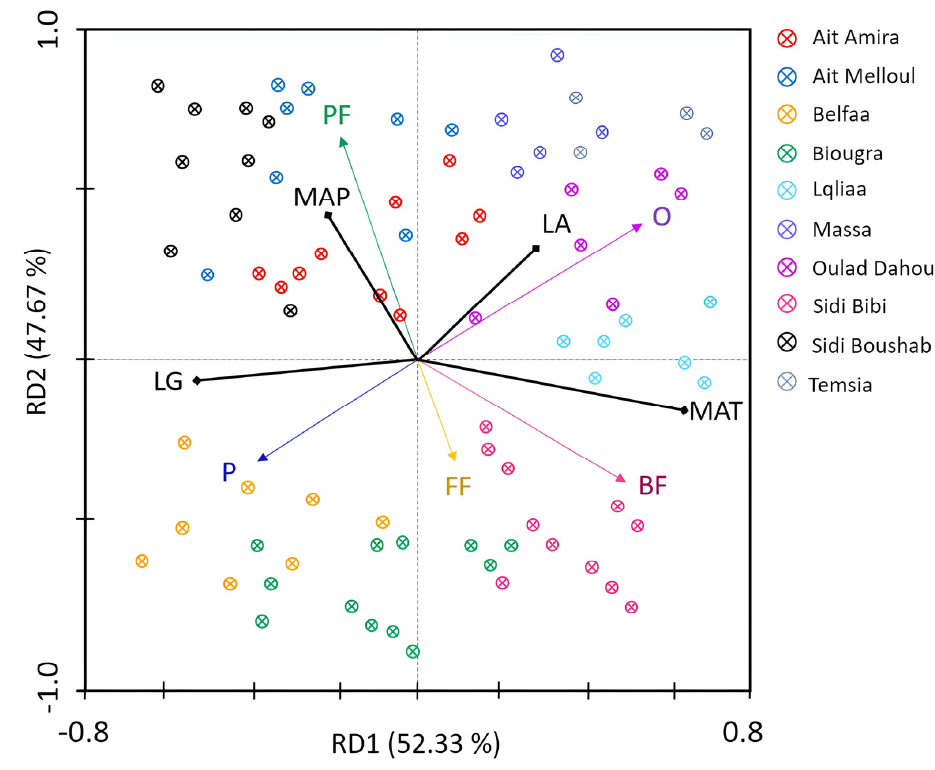
Figure 11. Redundancy analysis (RDA) of soil nematode taxa and environmental factor variables (LA—latitude; LG—longitude; MAP—mean annual precipitation; MAT—mean annual temperature). Soil nematodes are grouped into 4 trophic guilds (BF —bacterial feeders, FF—fungal feeders, PF—plant feeders, O—omnivores, and P—predators); Crossed circles indicate sampling localities; the bold black lines indicate environmental factors. The plot was generated by Python matplotlib and ordination libraries (skbio.stats.ordination) [61].